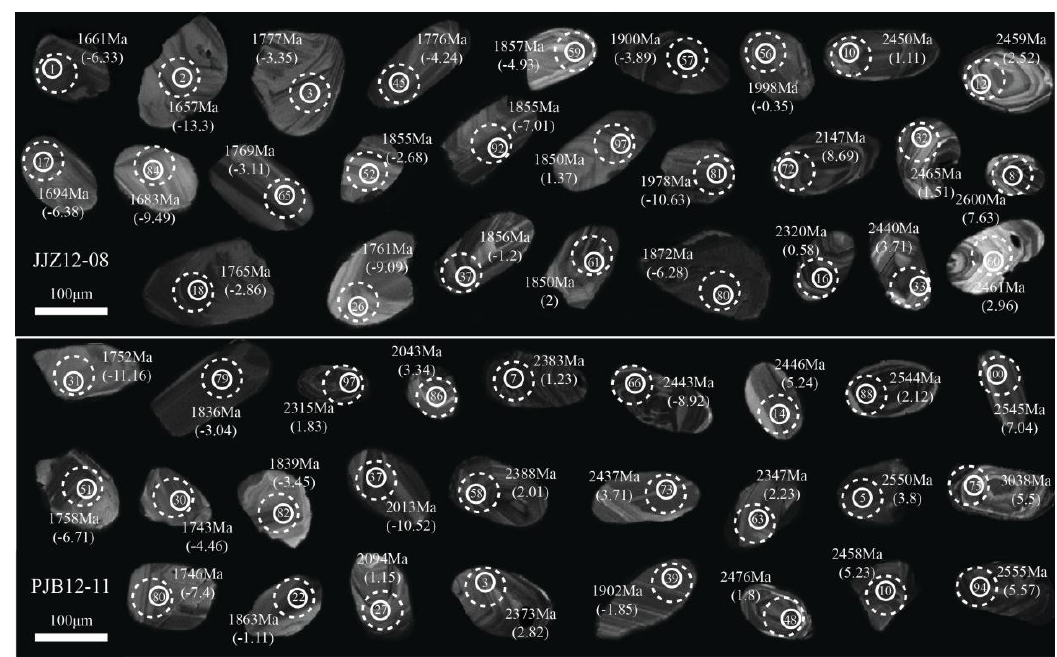
Figure 4. Representative zircon grain cathodoluminescence (CL) images with 207 Pb/ 206 Pb ages, and εHf ( t ) values (within parentheses). The analysis positions are shown, with solid lines for 207 Pb/ 206 Pb ages and dashed lines for Hf isotope values.